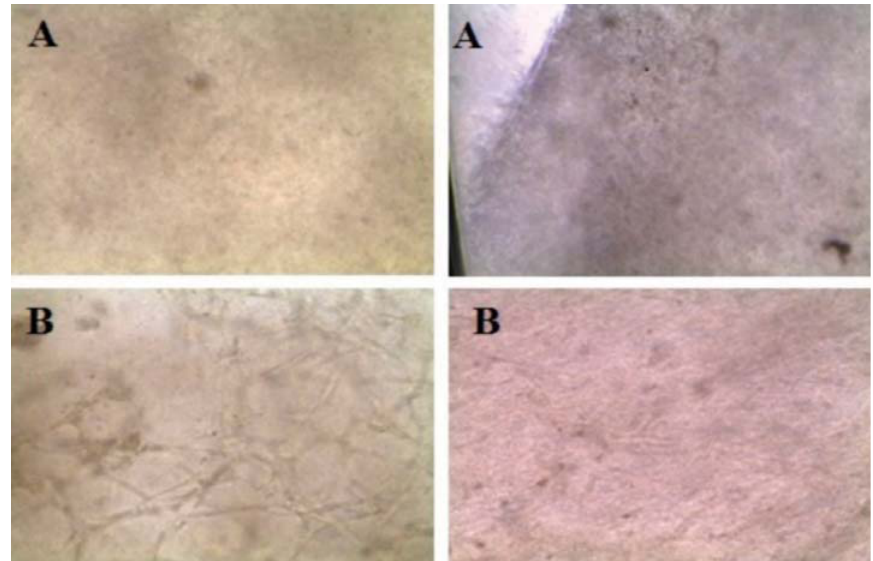
Figure 4- A. Dermal-epidermal substitutes of healthy subjects observed under the inverted microscope (40X). A globular pattern is (cid:82)(cid:69)(cid:86)(cid:72)(cid:85)(cid:89)(cid:72)(cid:71)(cid:17)(cid:3)(cid:37)(cid:17)(cid:3)(cid:39)(cid:72)(cid:85)(cid:80)(cid:68)(cid:79)(cid:16)(cid:72)(cid:83)(cid:76)(cid:71)(cid:72)(cid:85)(cid:80)(cid:68)(cid:79)(cid:3)(cid:86)(cid:88)(cid:69)(cid:86)(cid:87)(cid:76)(cid:87)(cid:88)(cid:87)(cid:72)(cid:86)(cid:3)(cid:82)(cid:73)(cid:3)(cid:71)(cid:76)(cid:68)(cid:69)(cid:72)(cid:87)(cid:76)(cid:70)(cid:3)(cid:86)(cid:88)(cid:69)(cid:77)(cid:72)(cid:70)(cid:87)(cid:86)(cid:3)(cid:82)(cid:69)(cid:86)(cid:72)(cid:85)(cid:89)(cid:72)(cid:71)(cid:3)(cid:88)(cid:81)(cid:71)(cid:72)(cid:85)(cid:3)(cid:87)(cid:75)(cid:72)(cid:3)(cid:76)(cid:81)(cid:89)(cid:72)(cid:85)(cid:87)(cid:72)(cid:71)(cid:3)(cid:80)(cid:76)(cid:70)(cid:85)(cid:82)(cid:86)(cid:70)(cid:82)(cid:83)(cid:72)(cid:3)(cid:11)(cid:23)(cid:19)(cid:59)(cid:12)(cid:17)(cid:3)(cid:36)(cid:3)(cid:191)(cid:69)(cid:85)(cid:76)(cid:79)(cid:79)(cid:68)(cid:85)(cid:3)(cid:83)(cid:68)(cid:87)(cid:87)(cid:72)(cid:85)(cid:81)(cid:3)(cid:76)(cid:86)(cid:3)(cid:82)(cid:69)(cid:86)(cid:72)(cid:85)(cid:89)(cid:72)(cid:71)